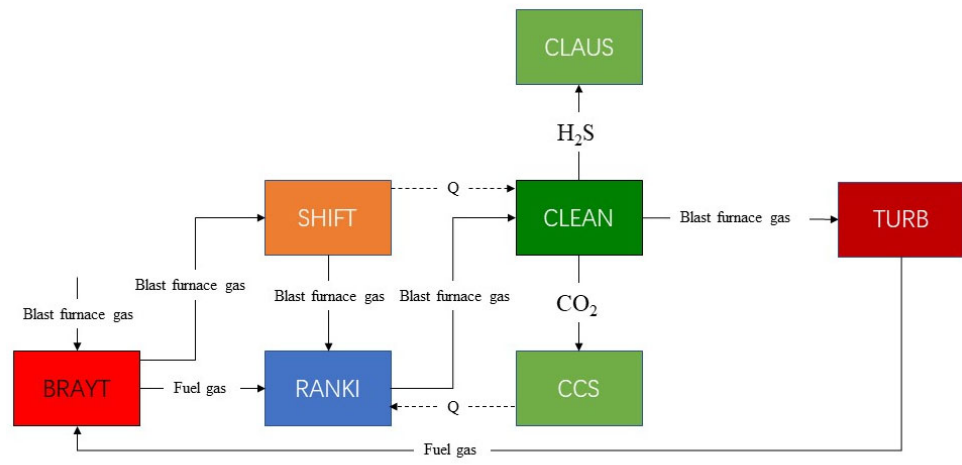
Figure 1. Schematic flow chart of the simulated system.